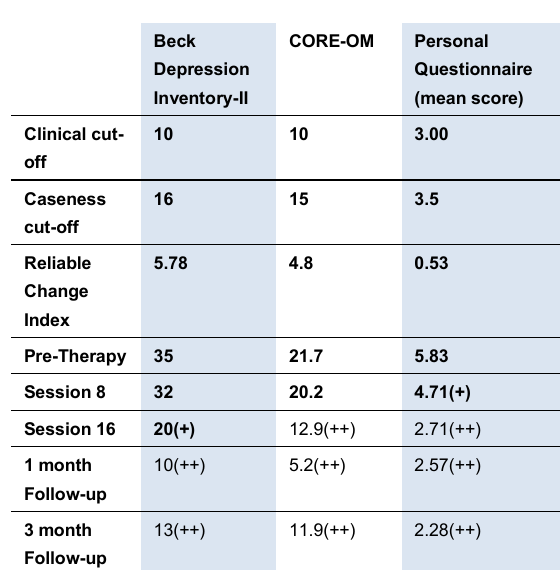
Table B1: Summary of Outcome